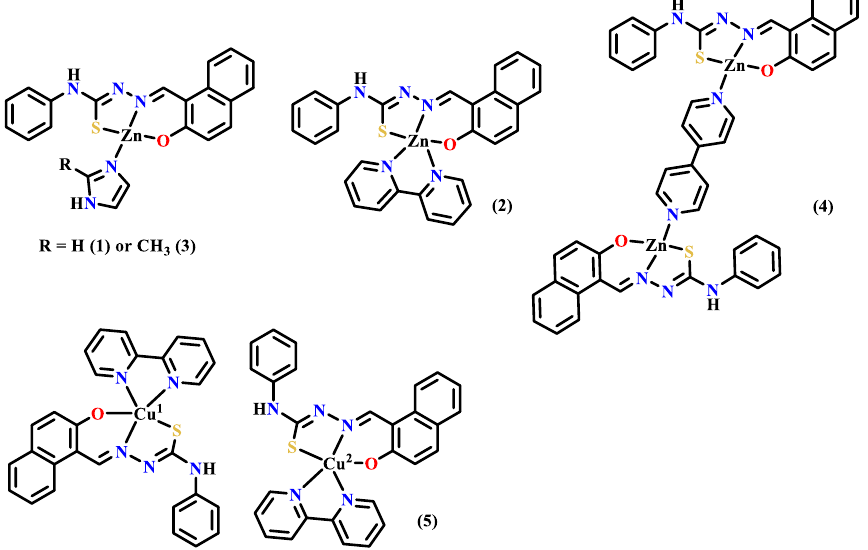
Figure 5. The Cu(II)/Zn(II) complexes of naphthylhydrazone with phenylthiourea as side chain together with several N -co-ligands.